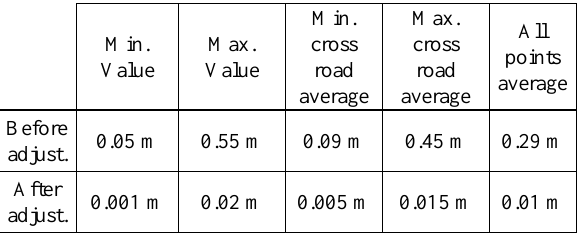
Table 2. Statistics of automatic differences between the created